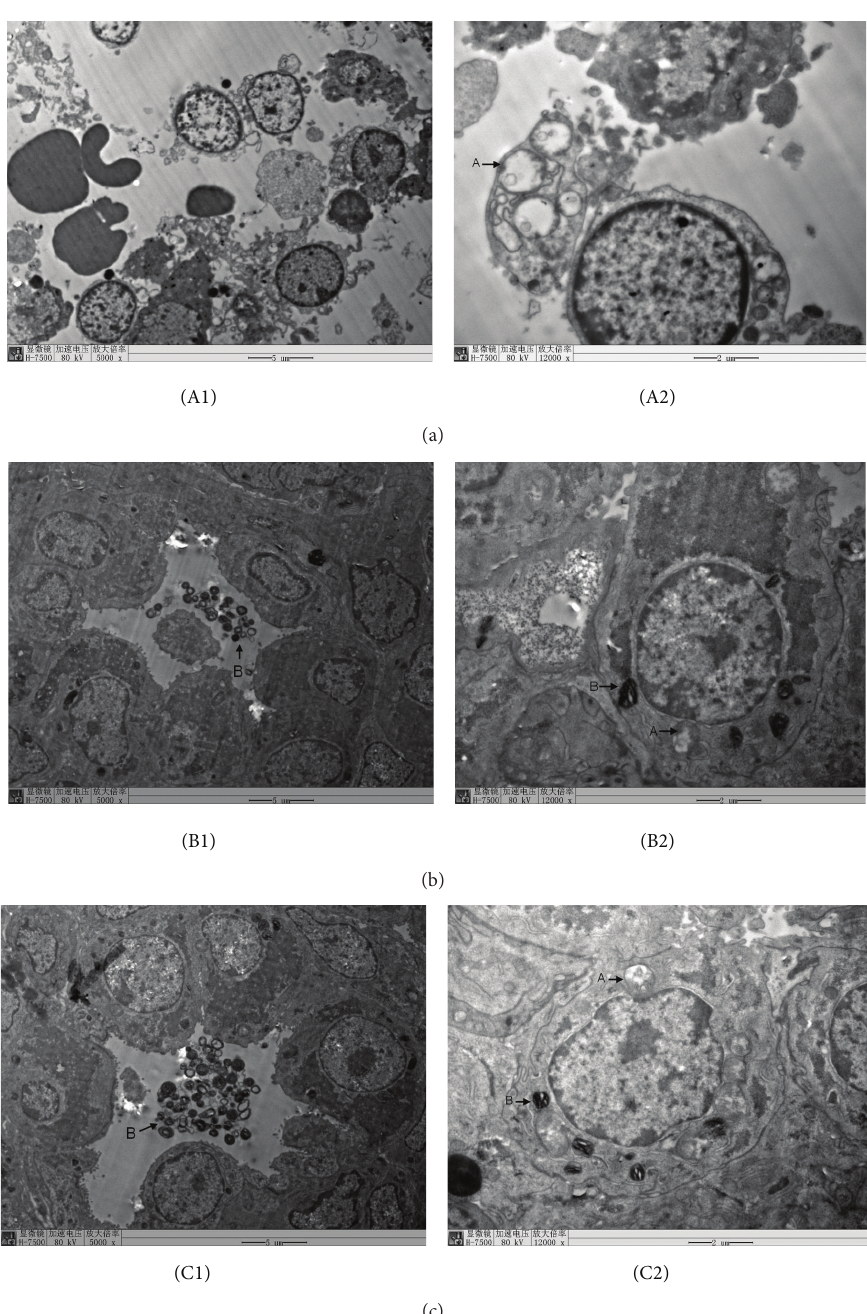
Figure 2: The morphology of fetal rat lungs in electronic microscope. (a) The high bile acid group: type II alveolar epithelial cells with swelling mitochondria were degenerated. Lamellar body had disappeared. A large number of red blood cells, proteins, cell debris falling, and edema fluid were filled in alveolar cavity. × 5000 (A1), × 12000 (A2). (b) The low bile acid group: type II alveolar epithelial cells with decreasing microvilli on the surfaces and slight swelling mitochondria were observed. × 5000 (B1), × 12000 (B2). (c) The experimental control group: type II alveolar epithelial cells were in good condition. A clear lamellar structure can be observed in lamellar bodies. × 5000 (C1), × 12000 (C2). Arrow A: swelled mitochondria (balloon-like); arrow B: lamellar body. in maternal serum of Group A ( 21.09±8.58 𝜇 mol / L) was sig- nificantly higher than that of Group B ( 10.49 ± 3.22 𝜇 mol / L), 𝑃 < 0.01 ; the level of TBA in Group B ( 3.98 ± 2.18 𝜇 mol / L) was significantly higher than that in Group C, 𝑃 < 0.01 , as shown in Table